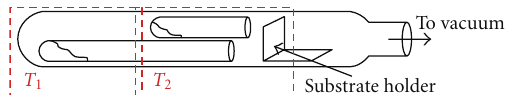
Figure 1: Two temperature zones reactor for gas phase reaction (1).